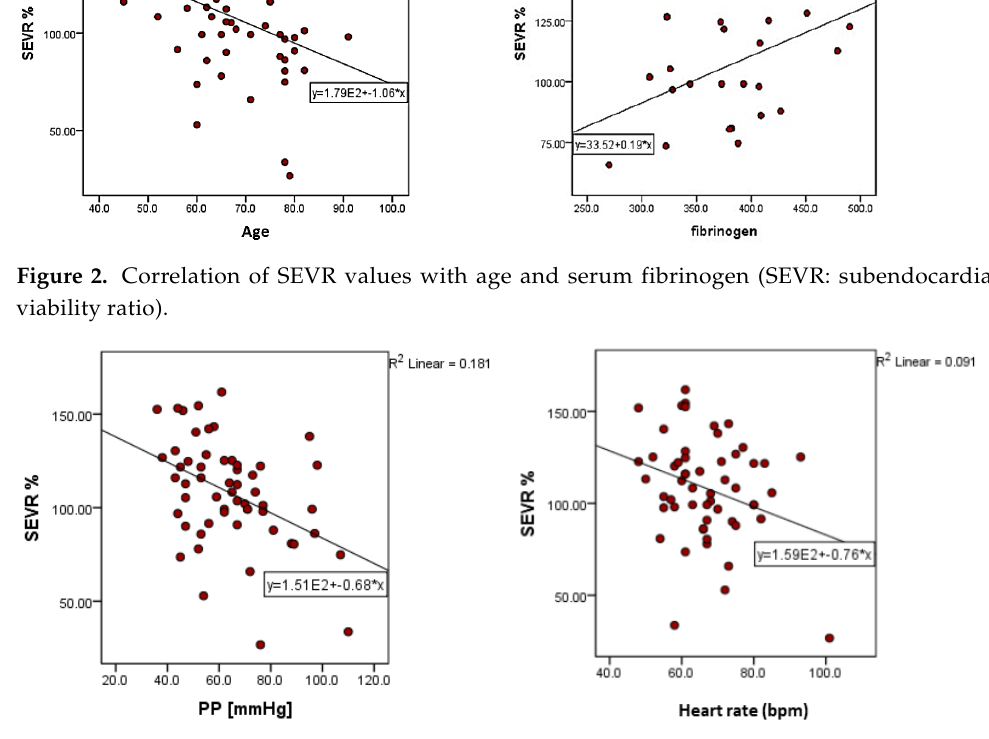
Figure 3. Correlation of SEVR values with pulse pressure and heart rate (SEVR: subendocardial viability ratio; PP: pulse pressure) .